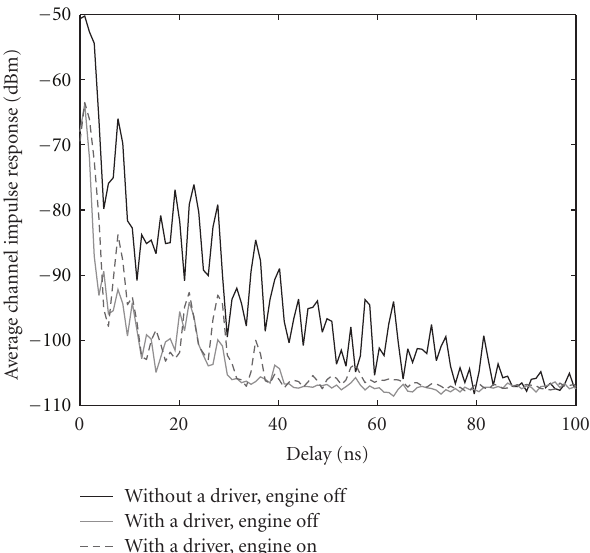
Figure 4: Average channel impulse responses for the ISM band for Rx17 (LOS) and the least square linear fitting curve in dB scale.